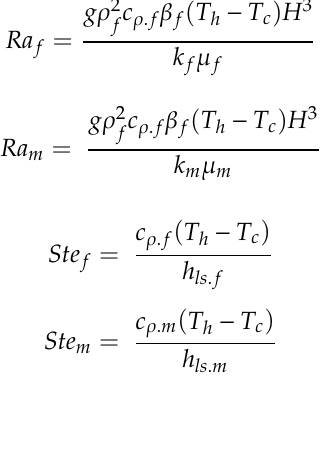
Figure 7. Produced fresh water in the presence and absence of PCM and nano-PCMs.